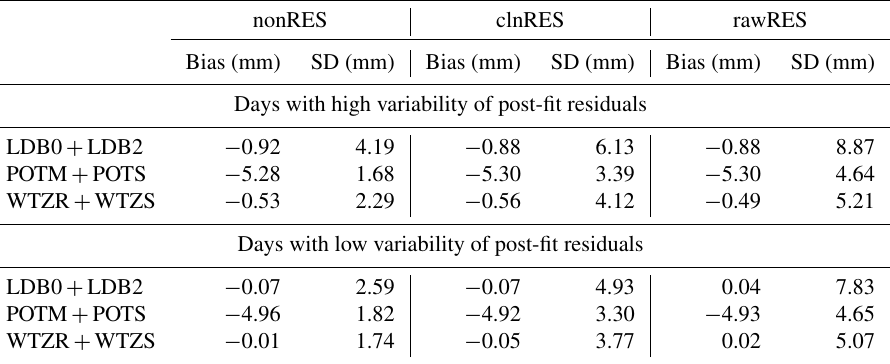
Table 8. Comparison of GNSS STDs from the elevation angles ranging from 15 to 90 ◦ at three dual stations; results for days with high daily variability of cleaned post-fit residuals (top) and results for days with low daily variability of post-fit residuals (bottom). Median values of biases and standard deviations (SD) calculated over all GNSS STD solutions are given; statistics are expressed in the zenith